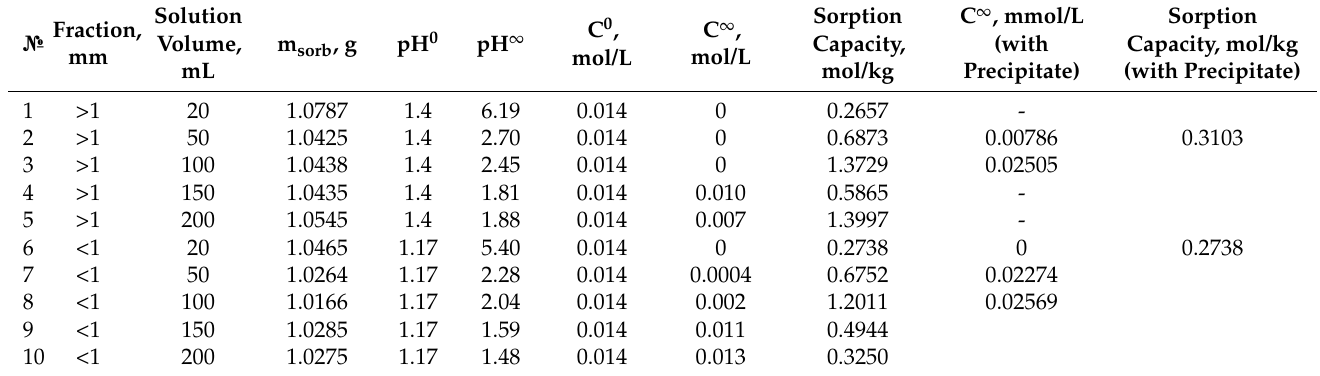
Table 5. Results of Pb 2+ sorption by organic material.